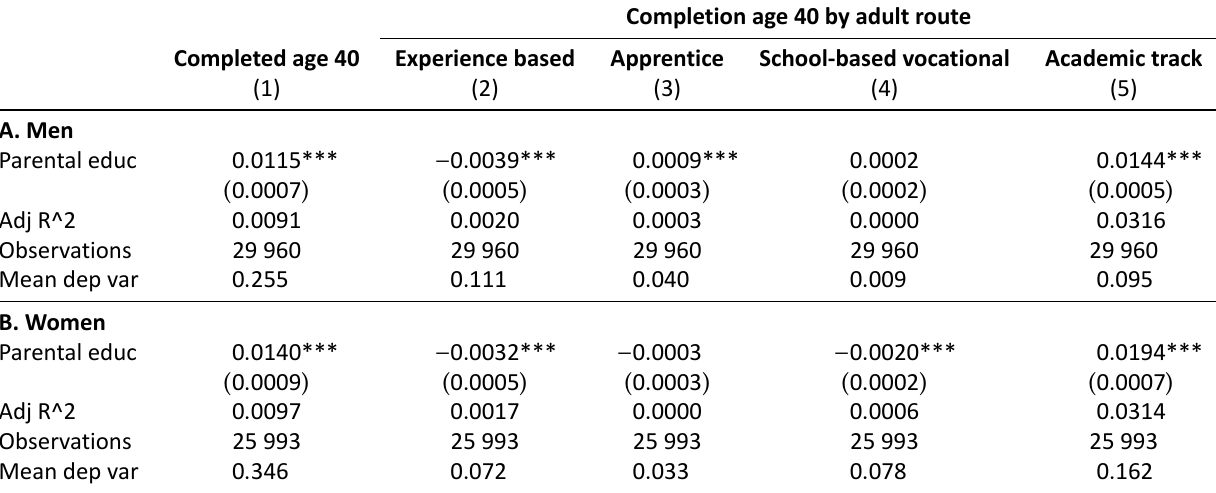
Table 3. Completion of upper secondary education, age 40. Conditional on dropout age 25.